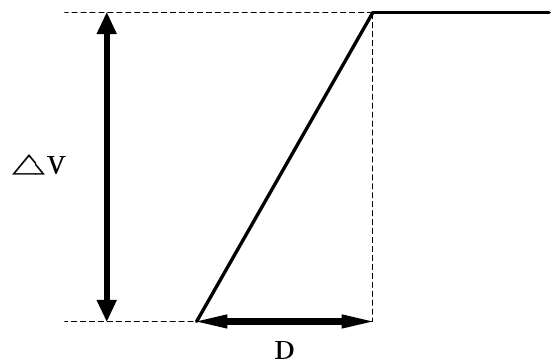
Figure 2. The principle of the conventional single ramp wind shear detection algorithm. Here, D is the length of the ramp, which represents the distance of the two data points, and ∆ V is the difference in wind speed between the two data point